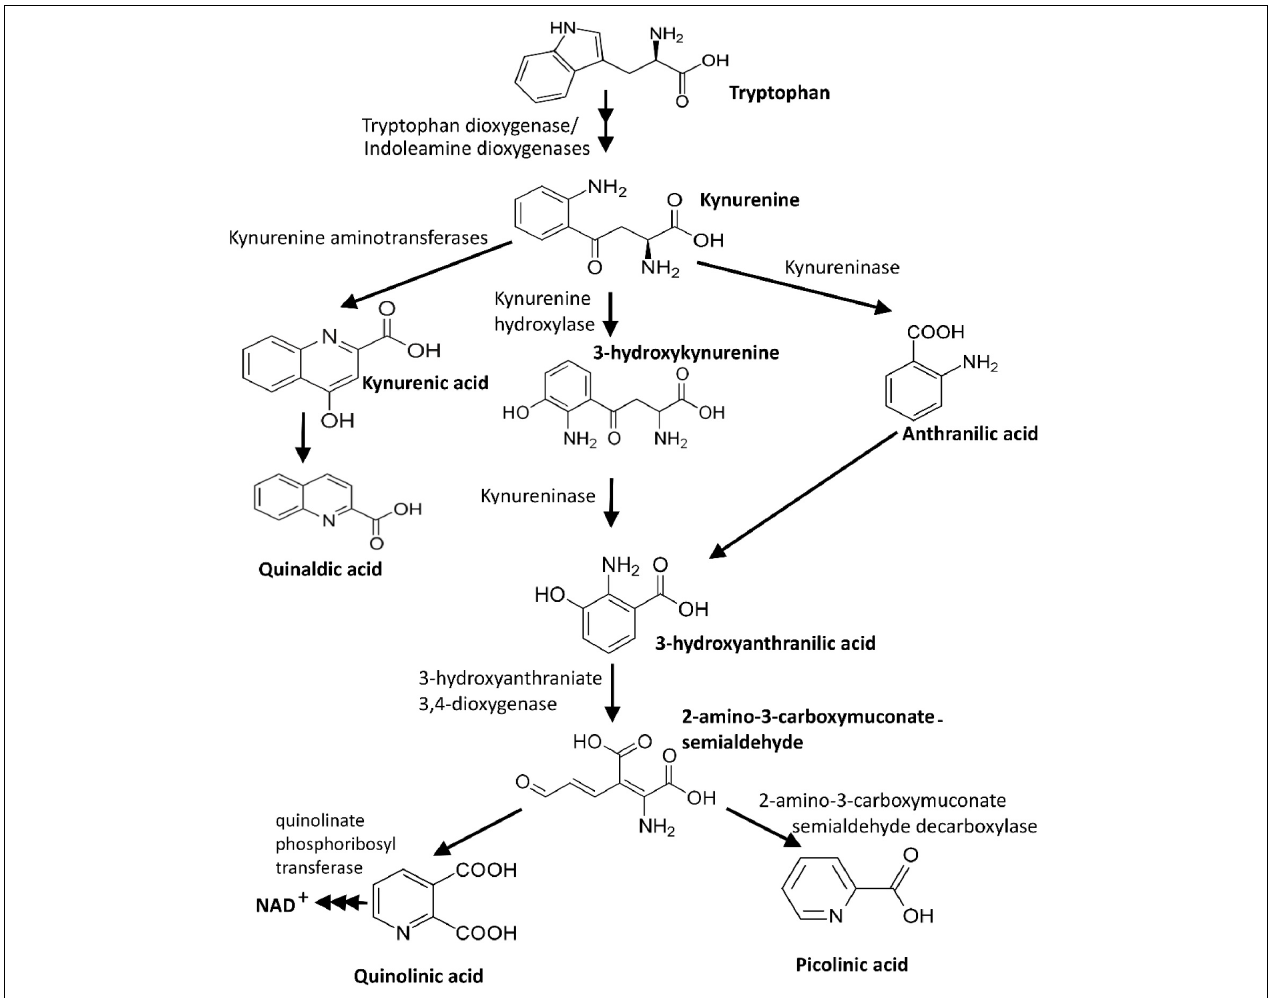
FIGURE 2 | Kynurenine pathway, the main route of tryptophan catabolism (Dehhaghi et al., 2019a).